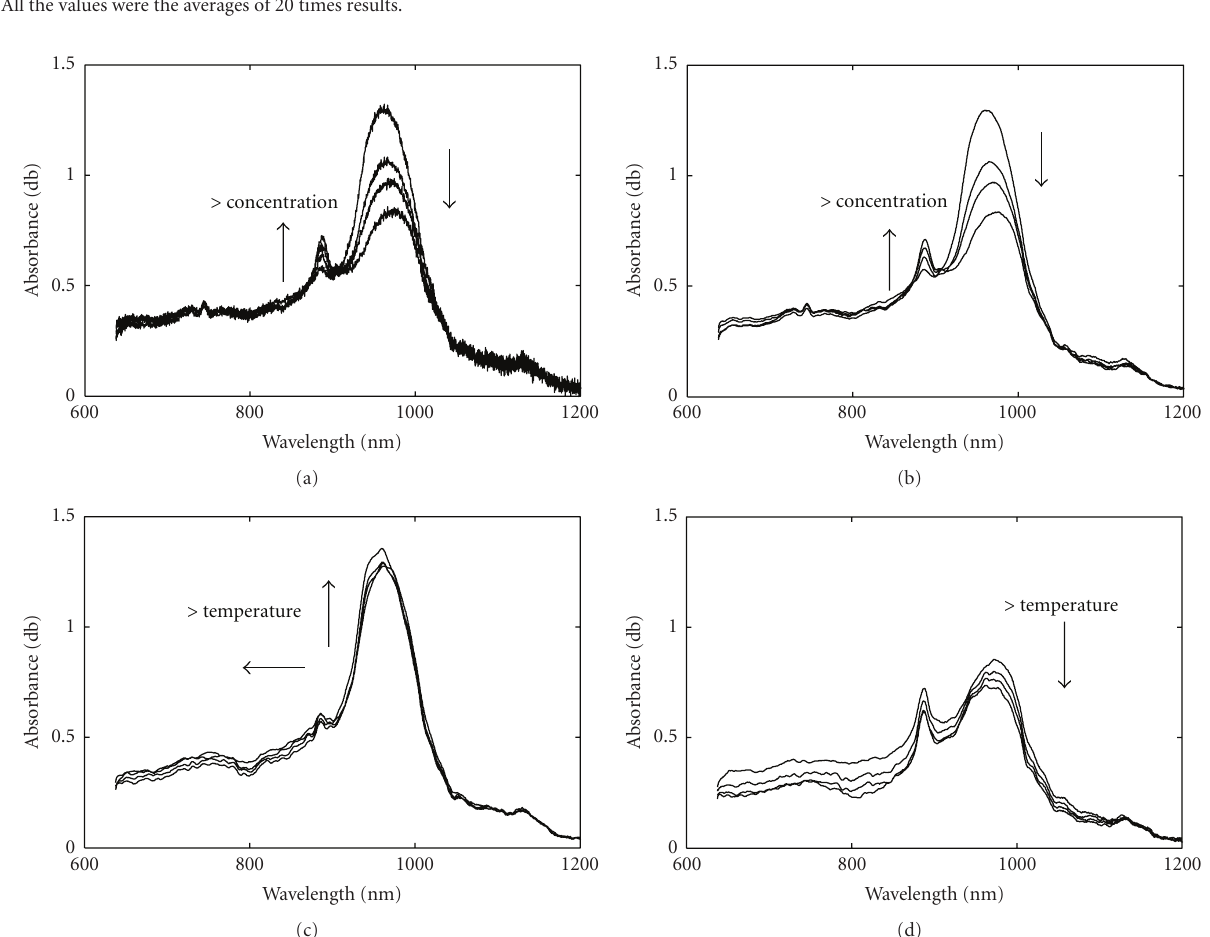
Figure 4: (a) Spectra of four alcohol contents at 25 ◦ C; the arrows indicate the increase of concentration. (b) the smoothed spectra of (a). (c) Spectra of 25% (v/v) alcohol at four temperatures; the arrows indicate the increase of temperature. (d) Spectra of 75% (v/v) alcohol at four temperatures; the arrow indicates the increase of